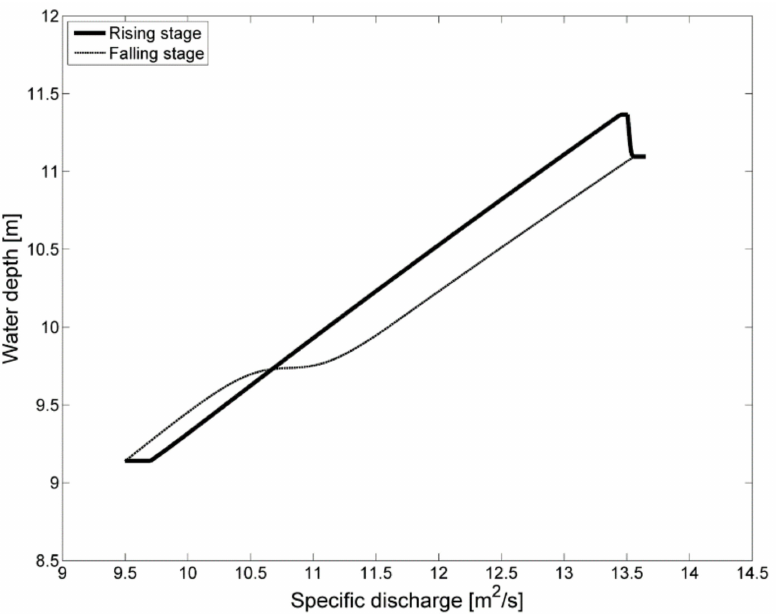
Figure 21. Specific discharge versus water depth separated for the rising and falling stages of the hydrograph, using the more extreme river